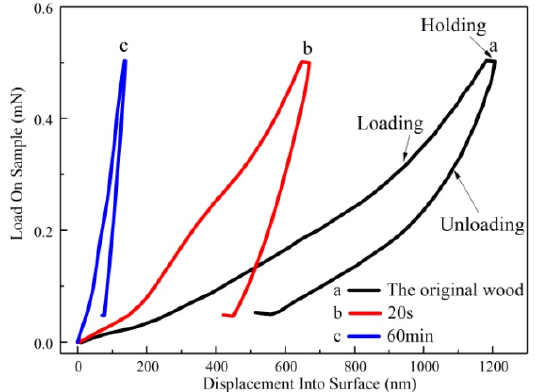
Figure 4. Load–displacement curve of nano-Al metallized wood.